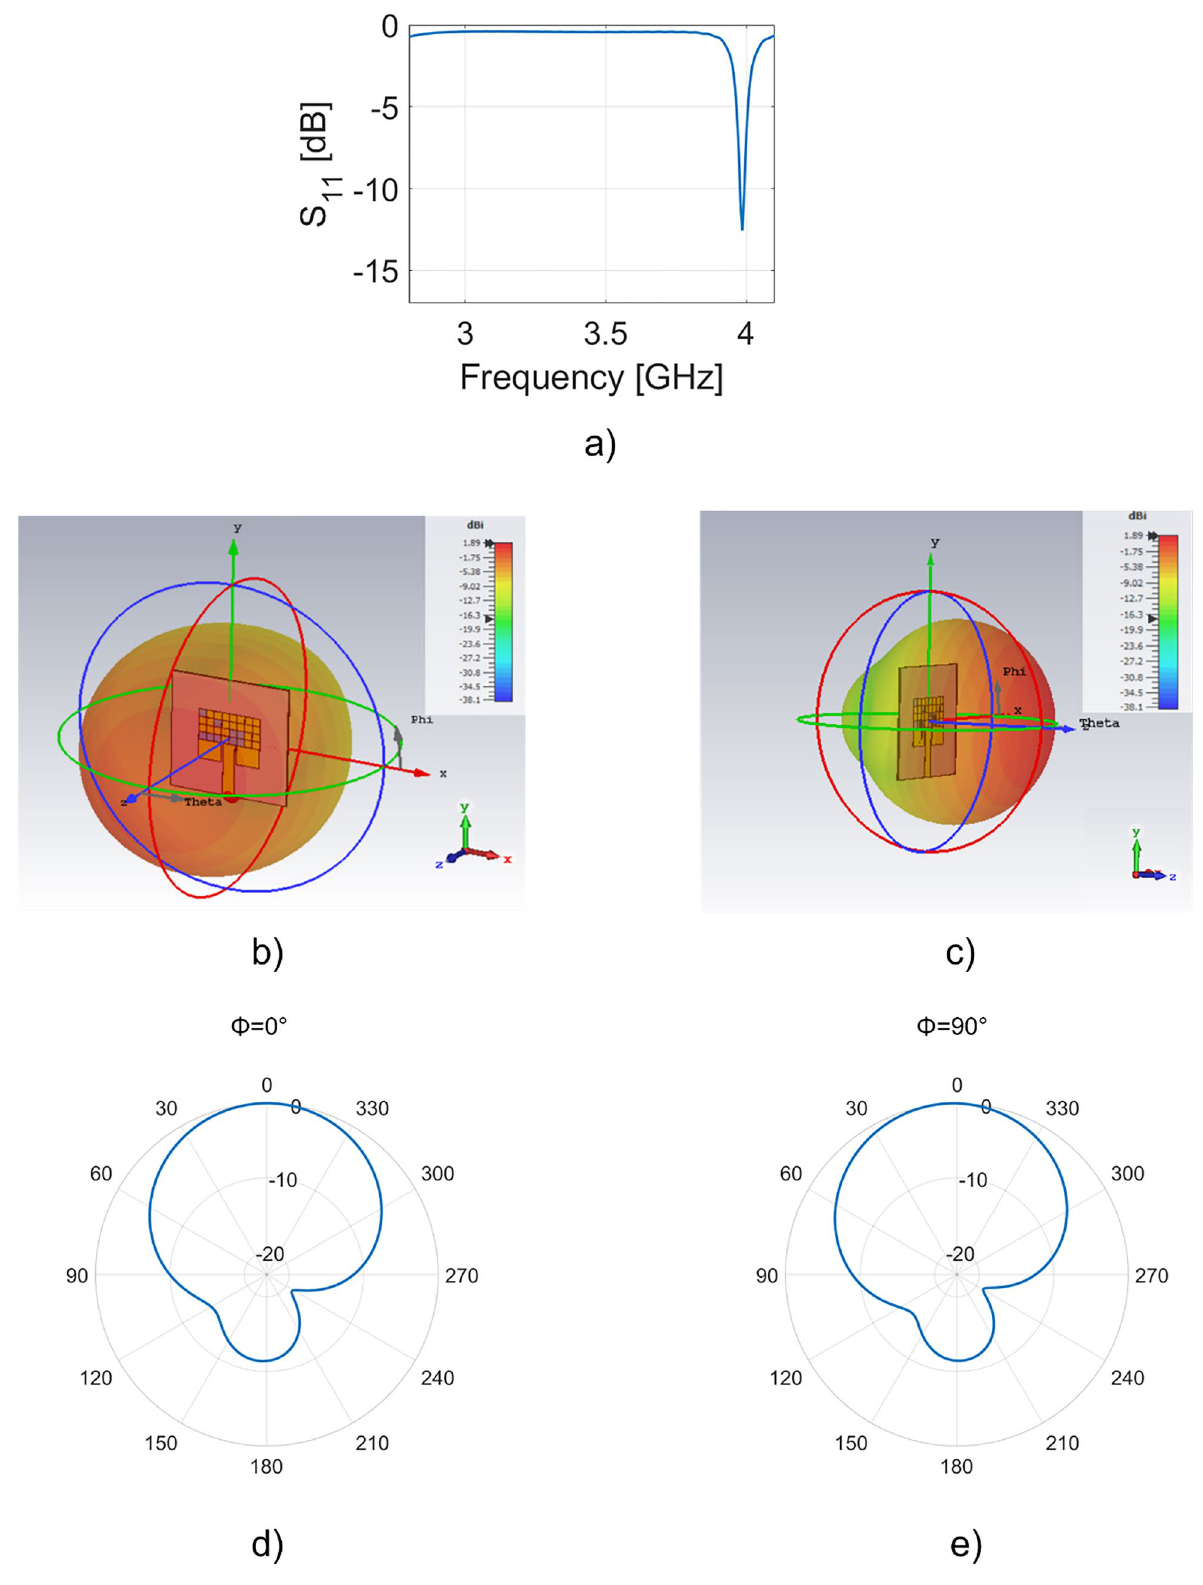
Figure 4. ( a ) Simulated S 11 parameter of the multilayer antenna, ( b ) front perspective and ( c ) side perspective of 3D radiation patterns at 3.985 GHz; simulated polar plot for the plane ( d ) ϕ = 0° and ( e ) ϕ = 90°. Software used: figure a Matlab R2020a; ( b – d ) CST Microwave Studio 2021. https:// it. mathw orks. com/, https:// www. 3ds. com/ produ cts- servi ces/ simul ia/ produ cts/ cst- studio-